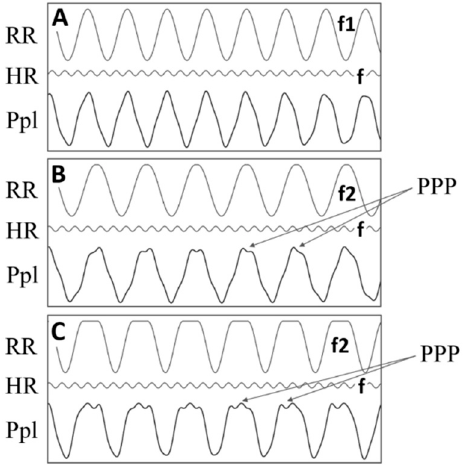
Figure 6. Schematic representation of the e ff ect of superposition of di ff erent amplitude and frequency waves on the visibility of the smaller amplitude component. RR, respiratory rate; HR, heart rate; P pl , pleural pressure; PPP, pleural pressure pulse. Upper waves in panels ( A – C ) represent respiratory derived fluctuations of P pl , please note that f2 respiratory frequency (rate) is lower than f1; middle waves in panels ( A – C ) correspond to heart derived fluctuations; bottom waves in panels ( A – C ) represent superposition of the upper and middle waves. ( Panel A ) Although low amplitude signal (HR) exists, it is invisible on the P pl curve when the ratio of the low and high amplitude signals (reflecting HR / RR) is relatively small (f / f1 = 3.1); ( Panel B ) low amplitude signal becomes visible when the HR / RR ratio becomes higher (f / f2 = 3.9); ( Panel C ) The best visibility of the low amplitude component can be achieved when HR / RR is high and there is a plateau phase on the peaks of the higher amplitude component. Note that although the smaller wave of the higher frequency is the same in all three cases, its influence is not clearly visible when f / f1 = 3.1 and that the visibility of small amplitude signal depends on the frequency ratio of HR and RR only, and it is independent of the specific values of HR and RR considered separately.